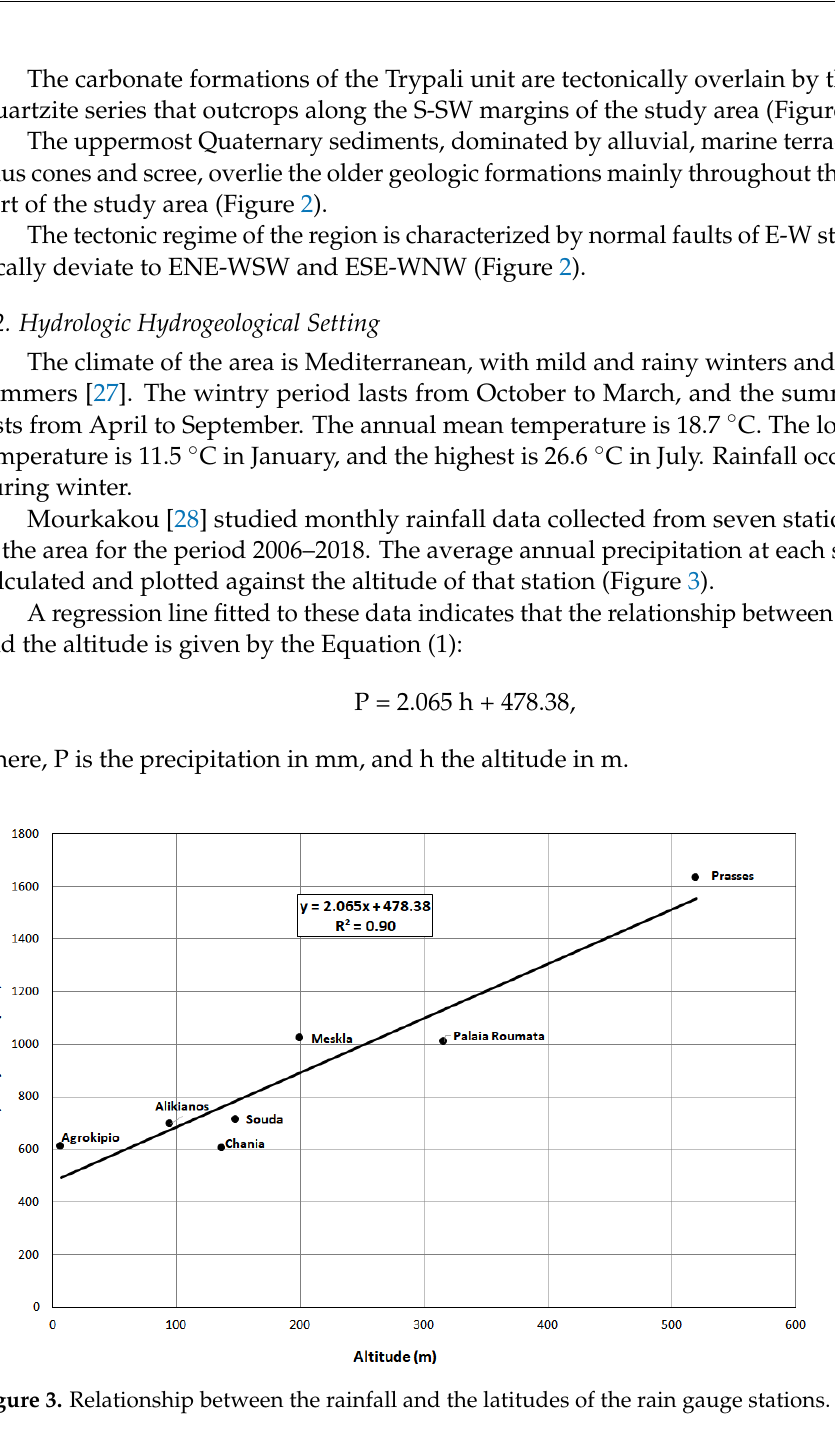
Figure 2. Geological map of the study area. The rectangle shows the area of the detailed flow model.